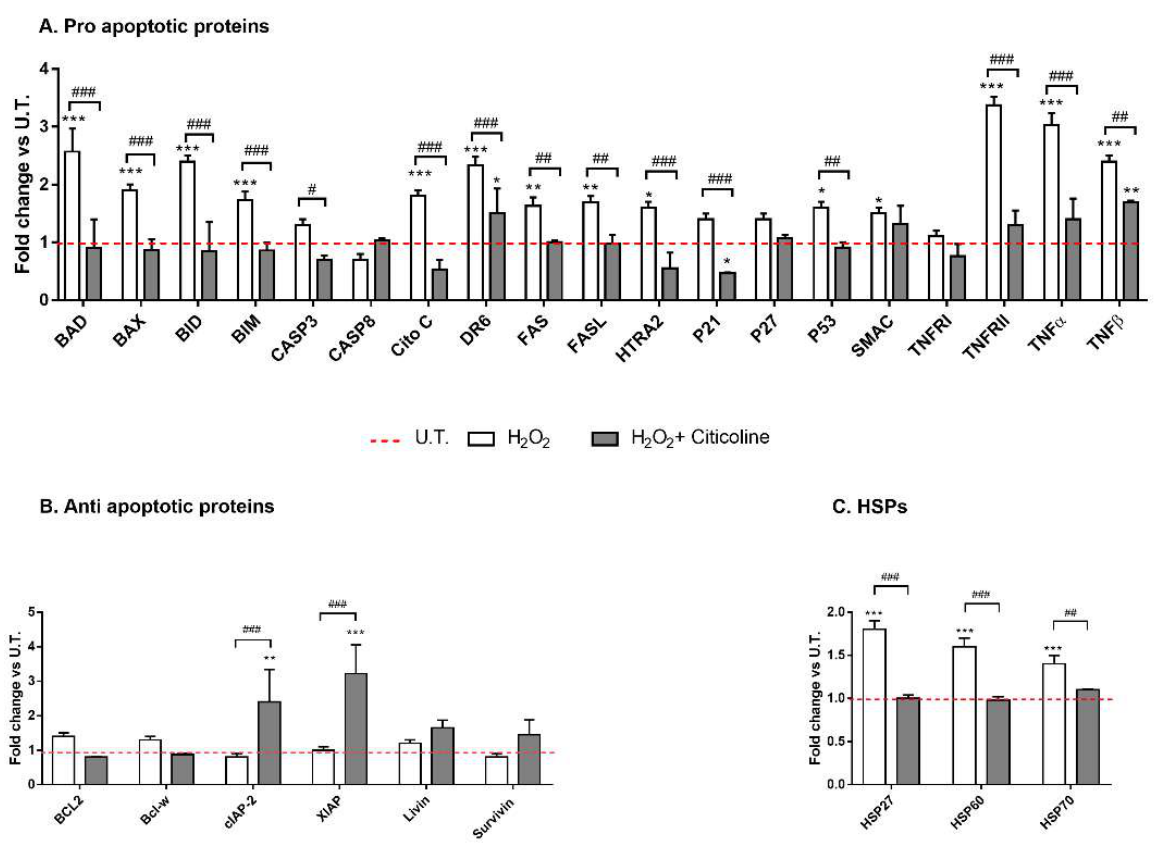
Figure 2. Apoptosis-array analysis. The analyses of ( A ) pro-apoptotic proteins, ( B ) anti-apoptotic proteins and ( C ) HSPs were performed after 48 h of experimental procedure by Human Antibody Array C1 (RayBio C-series). The red dotted line represents the protein level of untreated (UT) HTMCs for each of the proteins examined. Six individual models were arrayed and per experiment the intensity of Positive Control Spot was used to normalize signal responses for comparison results across multiple arrays. *** p < 0.001, ** p < 0.01; * p < 0.05 vs. UT HTMCs; ### p < 0.001, ## p < 0.01; # p < 0.05 vs. treated HTMCs (two-way ANOVA followed by Bonferroni post-test).